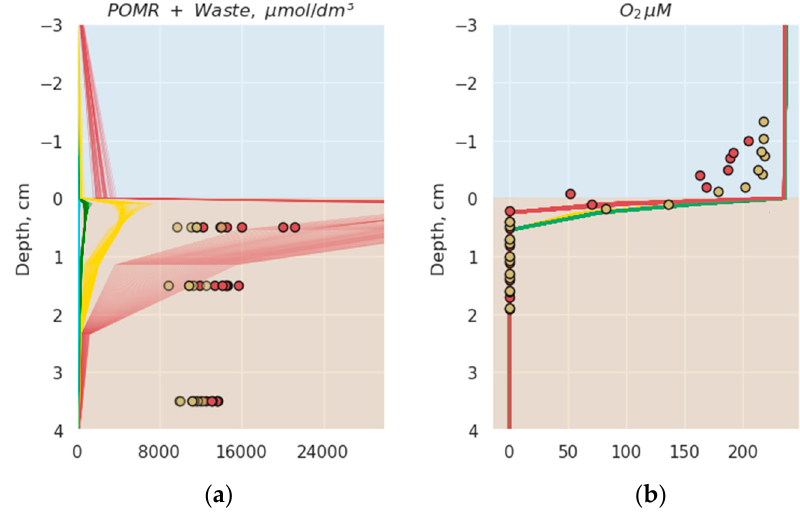
Figure 7. Modeled and measured distributions of particulate organic nitrogen and waste and observed POM (all in umol N / L) ( a ) and dissolved oxygen ( b ) in the bottom water and upper sediments. Colored lines show the distributions of modeled concentrations in the time interval ± 1 month relative to observations during the first year of farm functioning for di ff erent distances from a farm: 100 m (red), 500 m (yellow), 900 m (green), and 1400 m (blue). Red and yellow circles show sediment porewater concentrations observed at 100 and 500 m from a farm (stations 200 and 199, respectively).